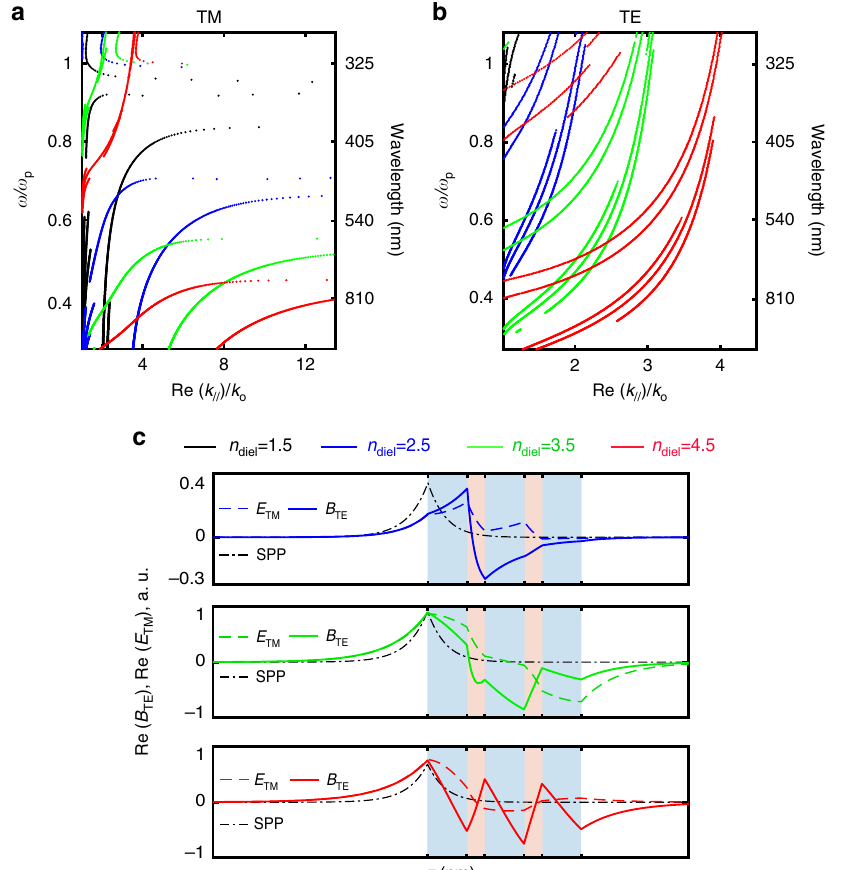
Fig. 5 Surface waves in magnetic hyperbolic layered metamaterials. a TM and b TE surface wave dispersion for a metamaterial consisting of fi ve alternating layers of dielectric n diel : 55 nm/Ag: 25 nm. c Field pro fi les (incidence from the left) and comparison with a surface plasmonic polariton (SPP) on an equivalent Ag slab (black dotted line). Calculations in c correspond to a wavelength of 620 nm for n diel = 2.5, 880 nm for n diel = 3.5 and 1100 nm for n diel = 4.5. Blue shaded regions in c indicate dielectric layers whereas pink shaded regions indicate